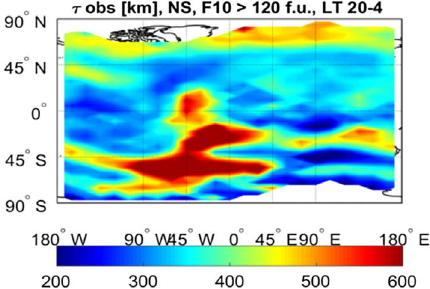
Fig. 18. Global map of the equivalent slab thickness for Southern winter at night (20 – 04 LT) and high solar activity